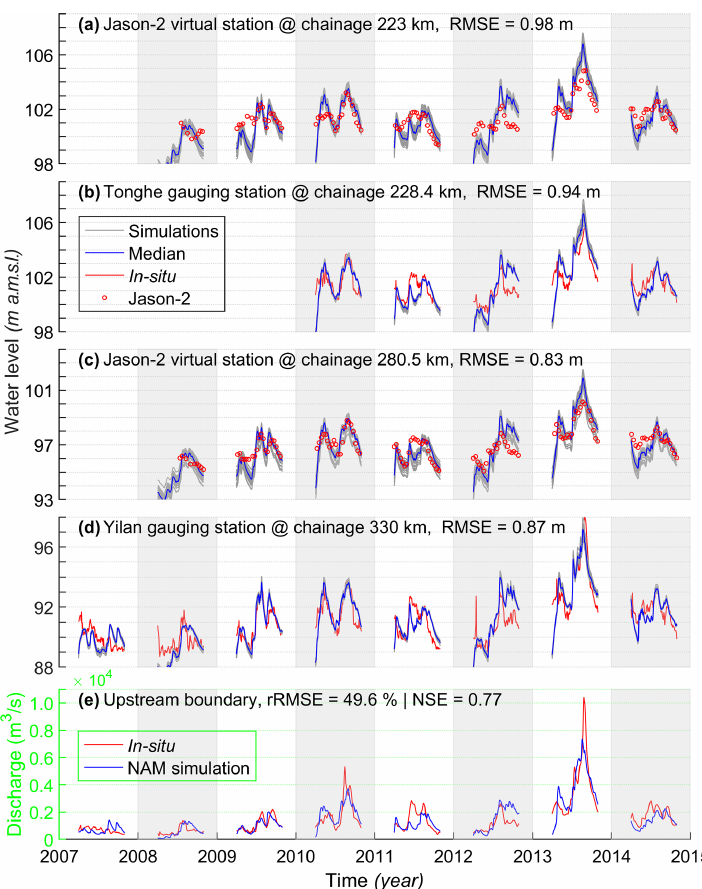
Figure C3. Similar to Fig. 6 but upstream boundary is rainfall-runoff model simulation instead of in situ discharge, which are shown in panel (e) . Note that NAM model was not calibrated at this